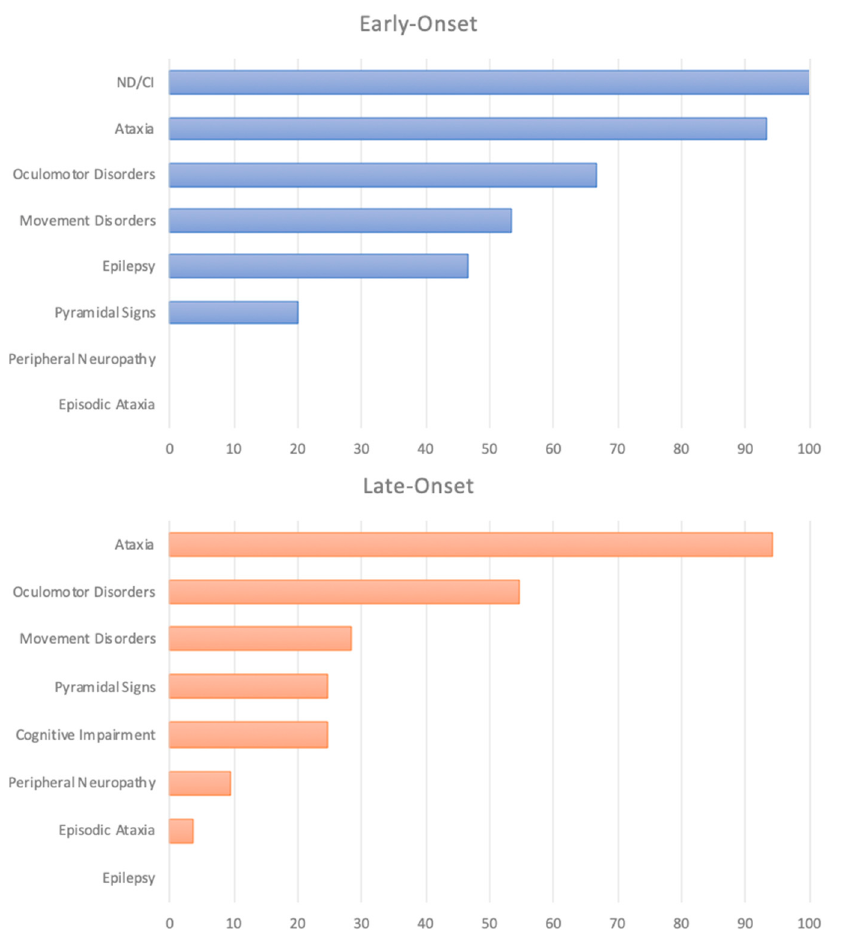
Figure 2. Percentage of symptoms in the early and late-onset cohort. ND: Neurodevelopmental disorders CI: Cognitive impairment.